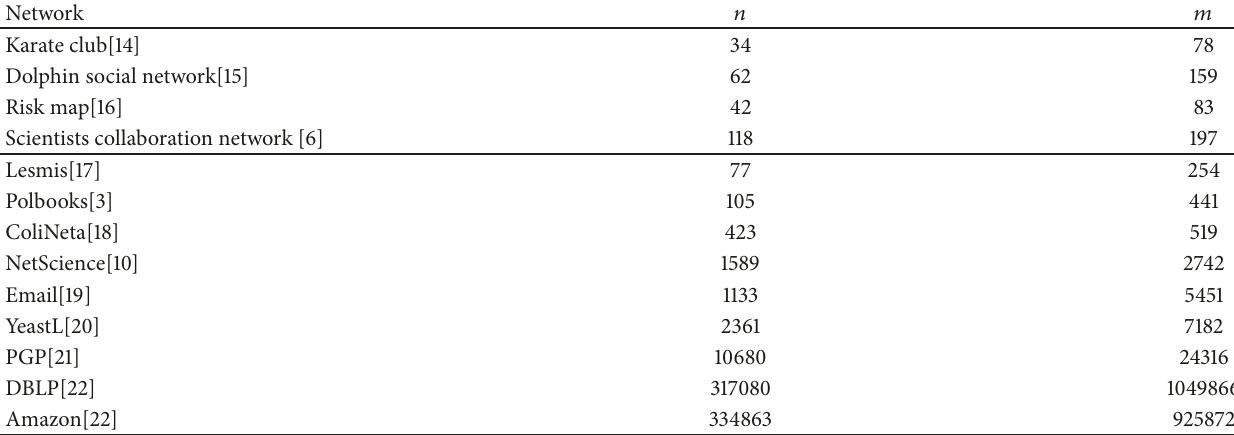
Table 2: The information about the real-world networks. 𝑛 and 𝑚 are the number of nodes and edges in the network, respectively. Network 𝑛